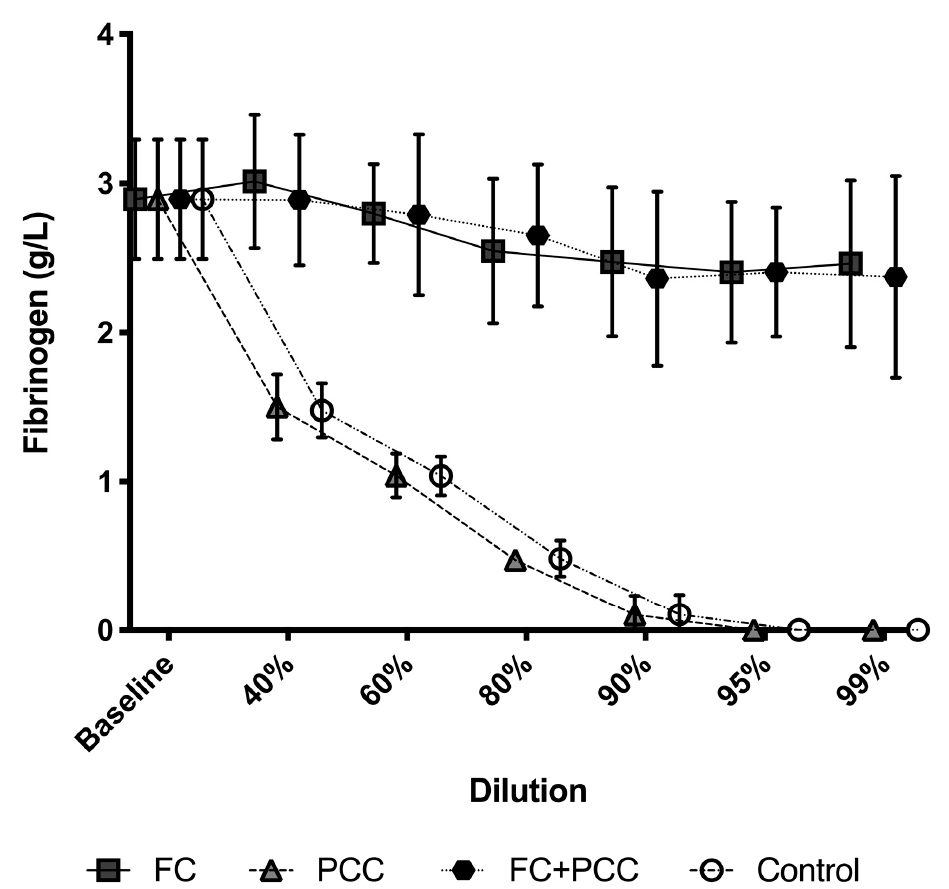
Figure 1. Fibrinogen concentrations in a comparison between the four study groups and different dilution levels. Significant differences ( p < 0.001) occurred at all dilution levels between the groups containing fibrinogen concentrate (FC, FC+PCC) and those that did not (PCC, Control). FC, fibrinogen concentrate group; PCC, prothrombin complex concentrate group; FC+PCC, combined fibrinogen and prothrombin complex concentrate group; Control, control group.